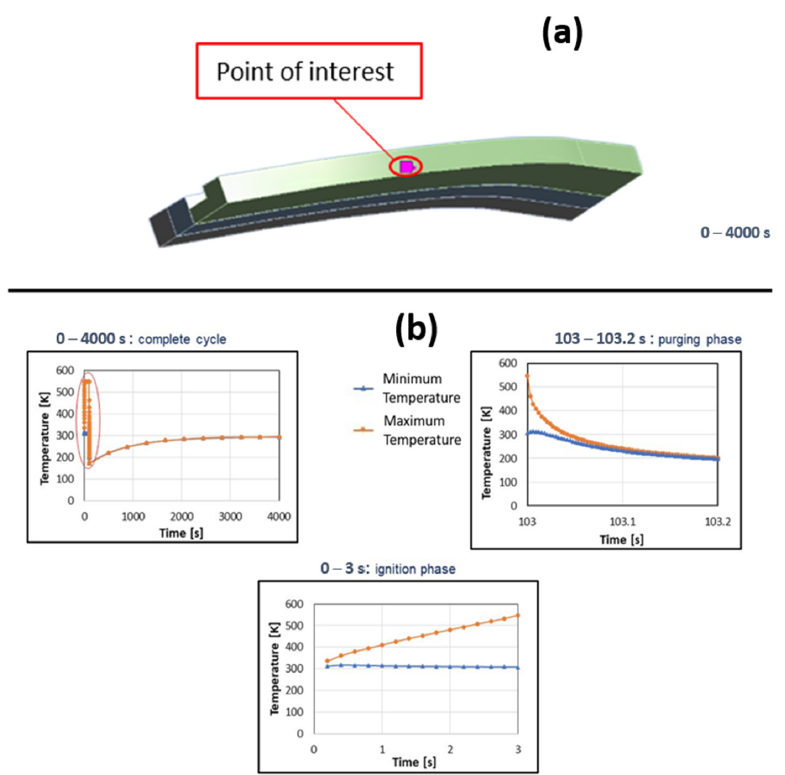
Figure 12. ( a ) Location of the node with the maximum equivalent plastic strain value, ( b ) Maximum and minimum temperature variations over time at the point of interest.